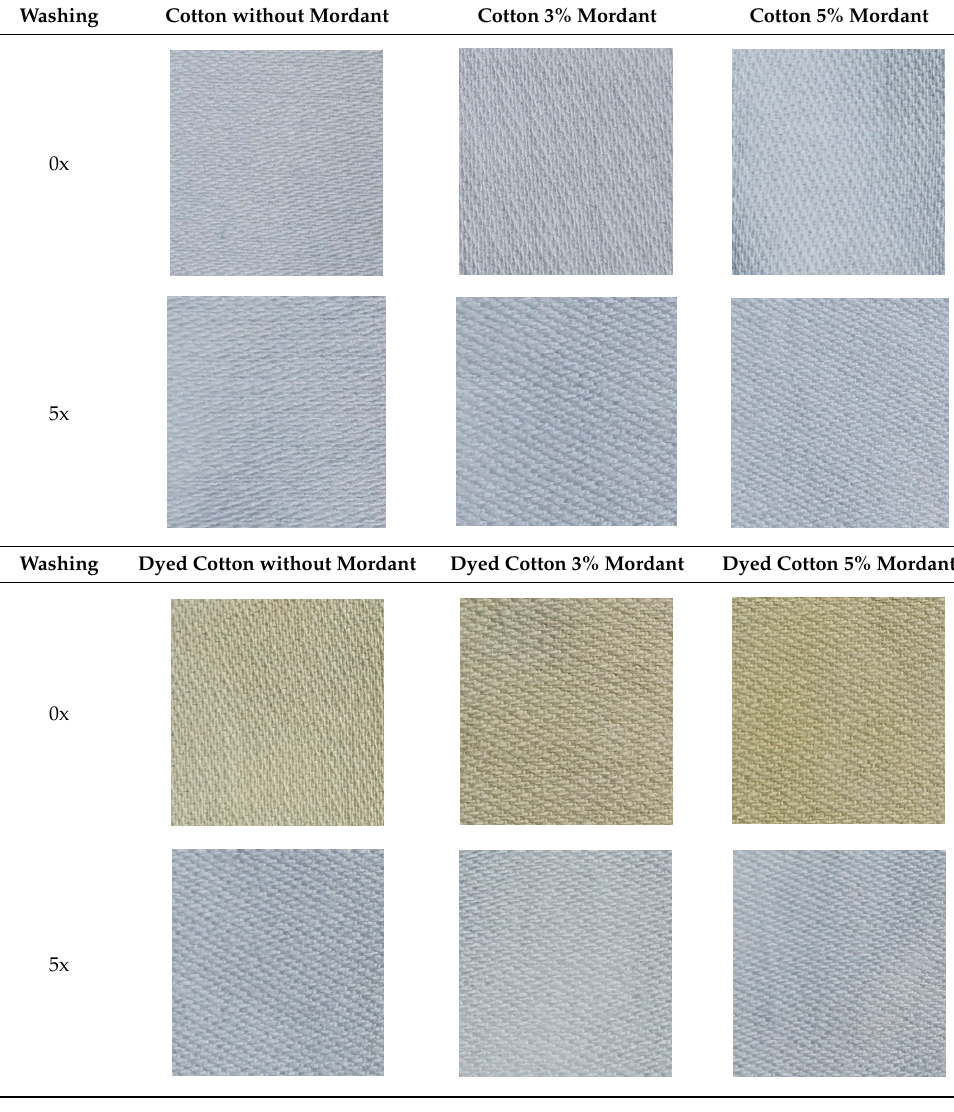
Table 12. Change in color coordinates of the wool sample without mordants after 1st, 3rd and 5th washing cycle (compared with W_0x).